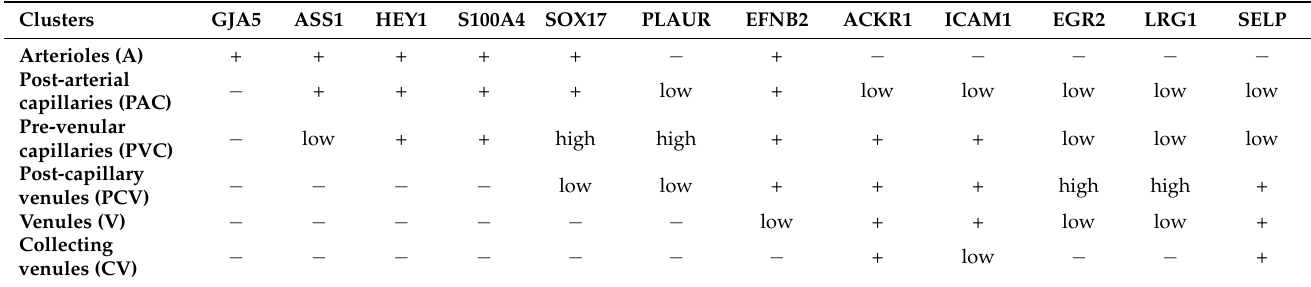
Table 1. Summary of marker expression in different BEC